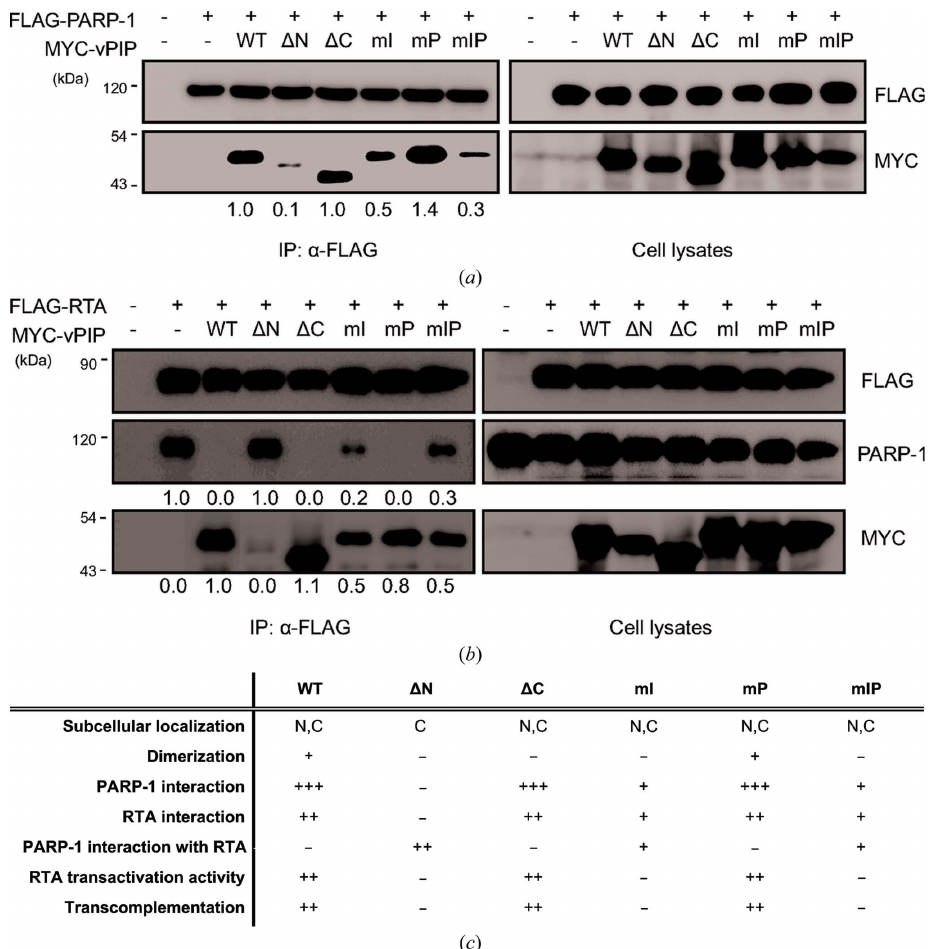
Figure 4 Molecular interactions of vPIP mutants with PARP-1 or RTA. ( a ) Interaction between vPIP mutants and PARP-1. MYC-tagged vPIP mutants were co-transfected with FLAG-tagged PARP-1 into HEK293T cells. The cells were harvested 48 h post-transfection and analyzed by co-IP assays with the anti-FLAG antibody. The results were examined by Western blotting. The band intensity of MYC in IP blots was measured using the ImageJ software. ( b ) Inhibition of interactions between RTA and PARP-1 by vPIP mutants. MYC- tagged vPIP mutants were co-transfected with FLAG-tagged RTA into HEK293T cells. The cells were harvested 48 h post-transfection and subjected to co-IP assays with the anti-FLAG antibody. The results were examined by Western blotting. The band intensity of PARP-1 and MYC in IP blots was measured in ImageJ . ( c ) A summary of subcellular localization, protein–protein interactions and functional activities of WT vPIP and